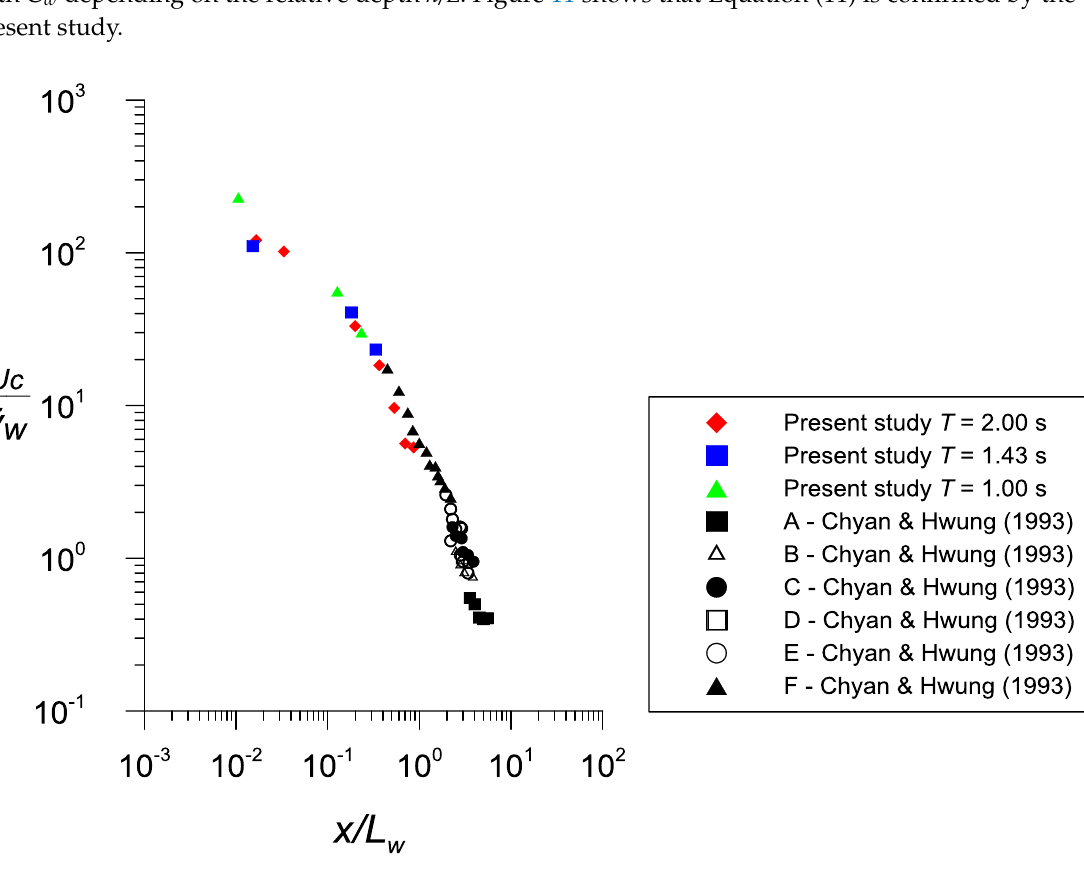
c along the dimensionless